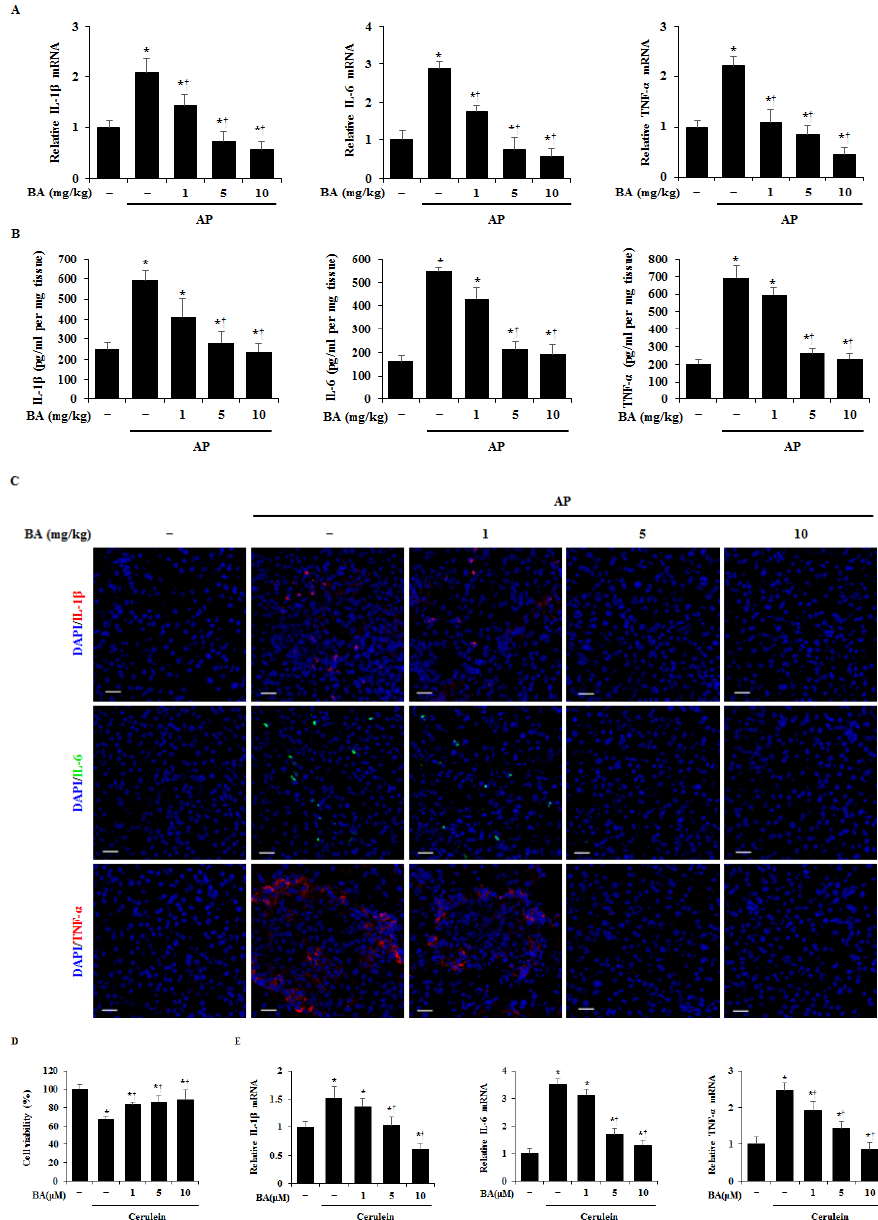
Figure 3. Effect of betulinic acid (BA) on production of proinflammatory cytokines. ( A ) Pancreatic mRNA levels of interleukin (IL)-1 β , IL-6, and tumor necrosis factor (TNF)- α were determined using reverse transcription-quantitative polymerase chain reaction (RT-qPCR). ( B ) Pancreatic protein levels of IL-1 β , IL-6, and TNF- α were measured by ELISA. ( C ) Confocal images of immunofluorescence staining of IL-1 β (red), IL-6 (green), TNF- α (red), and DAPI (blue). Scale bar = 20 µm. ( D ) Pancreatic acinar cells (PACs) were pretreated with BA (10 µM) for 1 h and then stimulated with cerulein (10 nM) for 6 h. The cell viability was measured as described in the experimental protocol. ( E ) PACs were pretreated with BA for 1 h at the indicated dose, and then stimulated with cerulein (10 nM) for 24 h. mRNA levels of IL-1 β , IL-6, and TNF- α in PACs were determined using RT-qPCR. Data have been represented as mean ± SEM for six mice in each group. Results are representative of three experiments. * p < 0.05 vs. dimethyl sulfoxide (DMSO) treatment alone. † p < 0.05 vs. cerulein treatment alone.